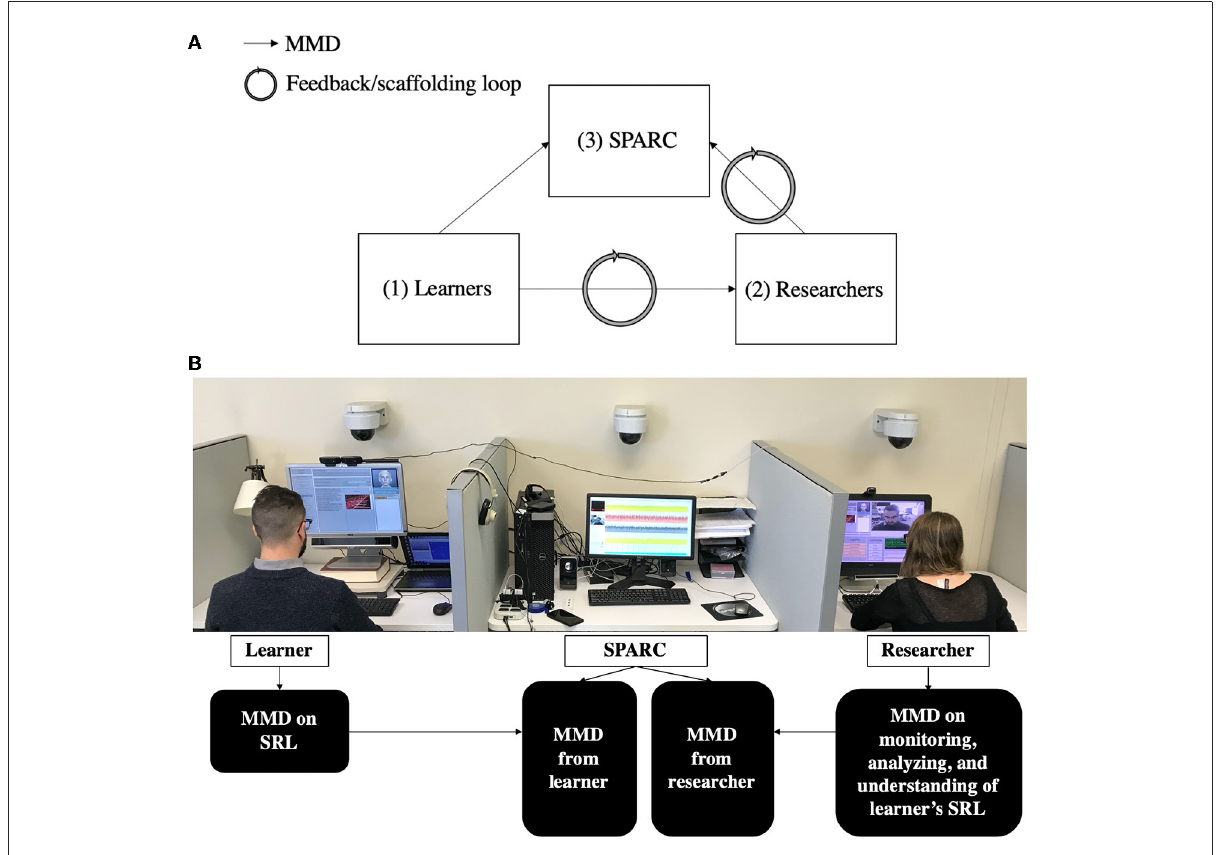
FIGURE3 (A) SPARC capturing the learner’s and researcher’s multimodal data; (B) Hierarchical architecture for data processing and feedback/scaffolding loops for both (1) learners and (2) researchers; MMD, multimodal